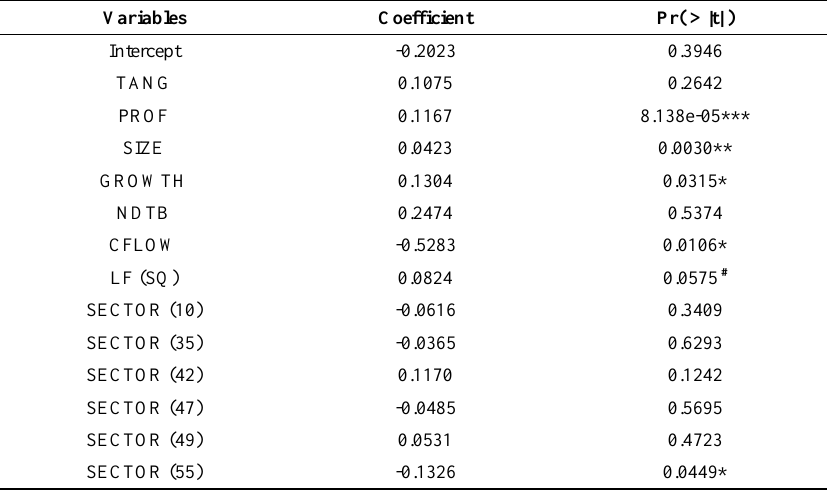
Table 4. Results of the OLS linear regression